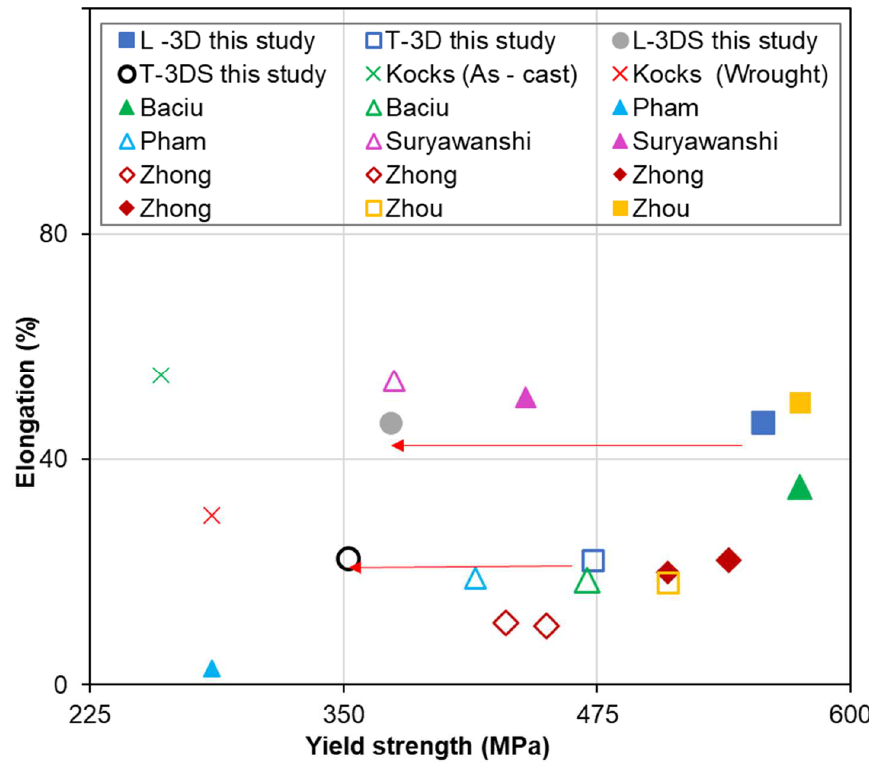
Figure 15. Relation between elongation and yield strength from literature and this study, red arrows show the effect of solution annealing.